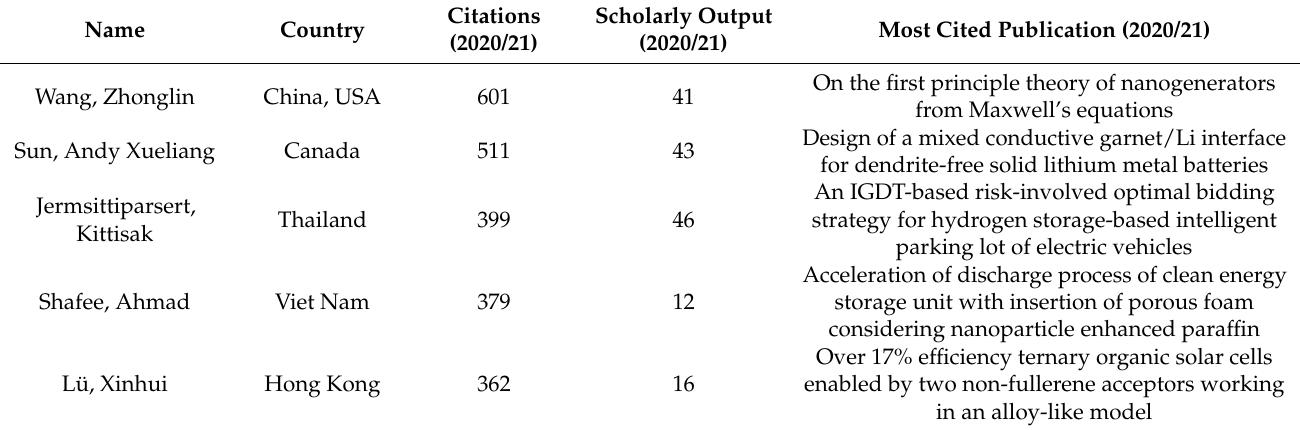
Table 5. Top 5 authors by the number of citations in Scopus on renewable energy, sustainability and the environment in